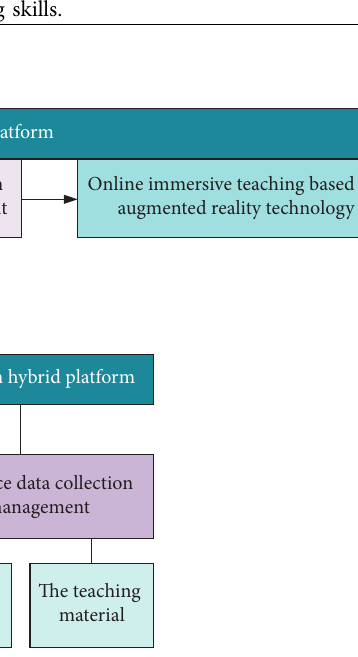
Figure 8: Data acquisition and the structure of the management